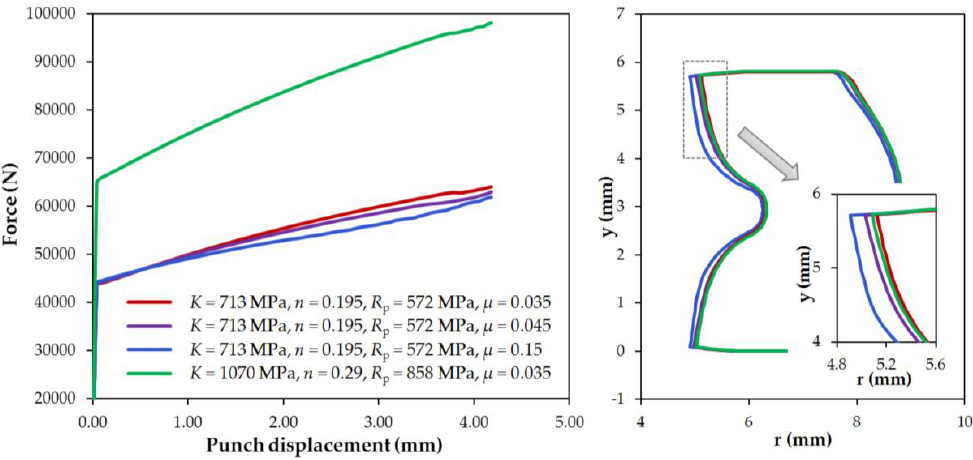
Figure 5. Influence of the material parameters and friction coefficient on the forming force ( left ) and specimen shape ( right ).